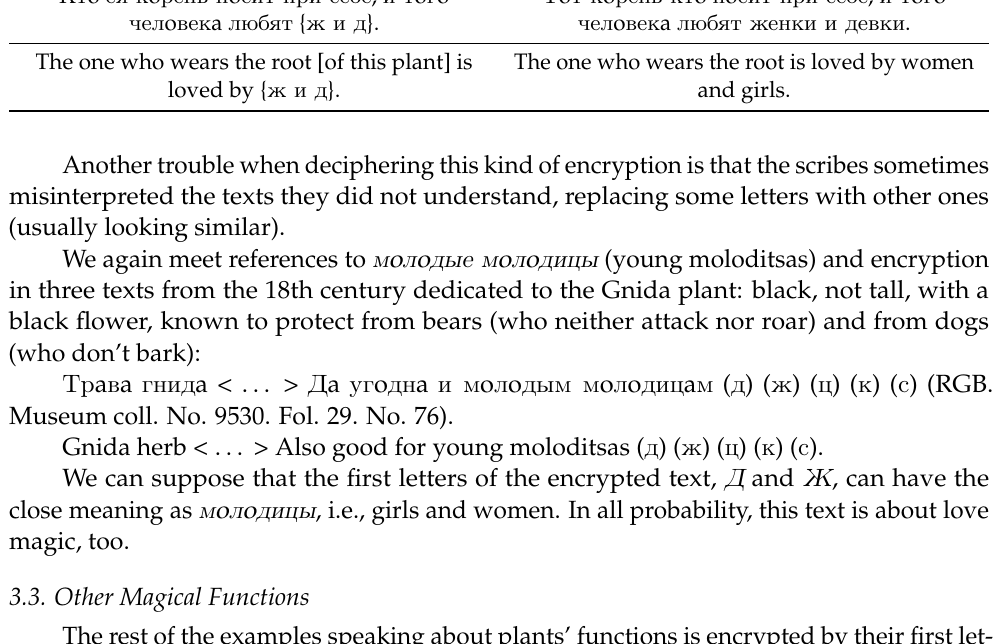
Table 3. Texts about the Peresyanka